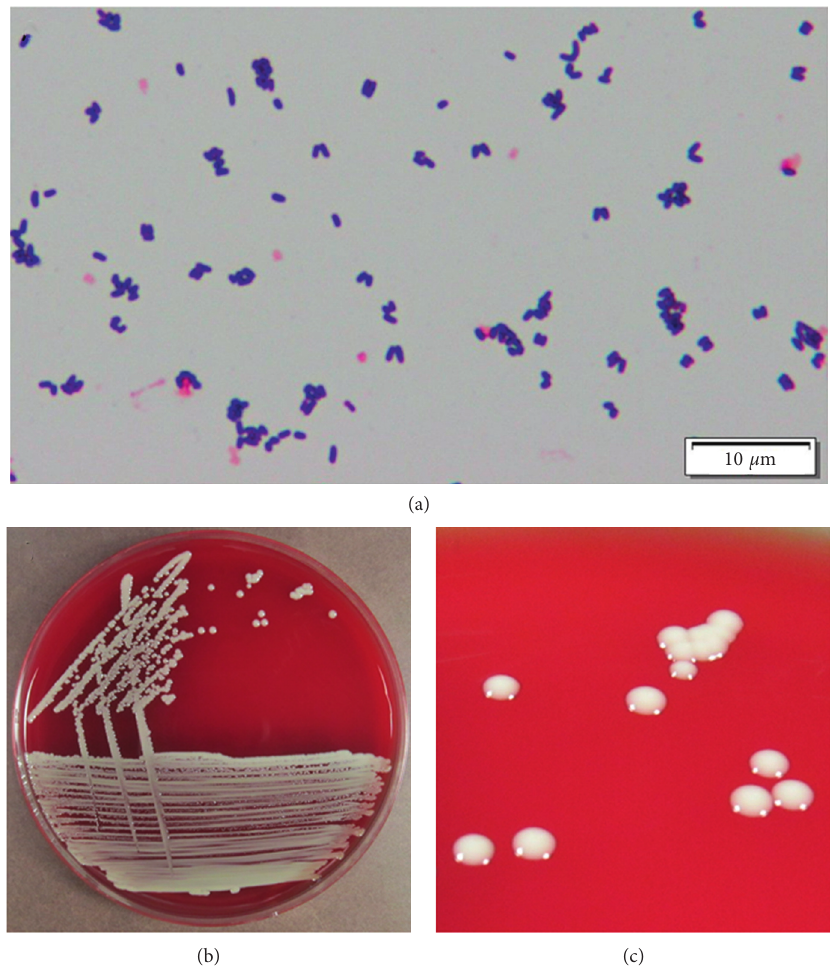
Figure 1: Macroscopic and microscopic appearance of Brevibacterium casei . (a) Gram-stained smears from blood samples cultured in bottles at 37 ° C for 24h. (b) Macroscopic appearance of B. casei colonies after isolation from the patient and culture on a sheep blood agar plate incubated at 37 ° C for 24 h in a CO 2 atmosphere. (c) The colonies appeared gray-white in color, non-hemolytic, smooth, and round and had a distinctive cheese